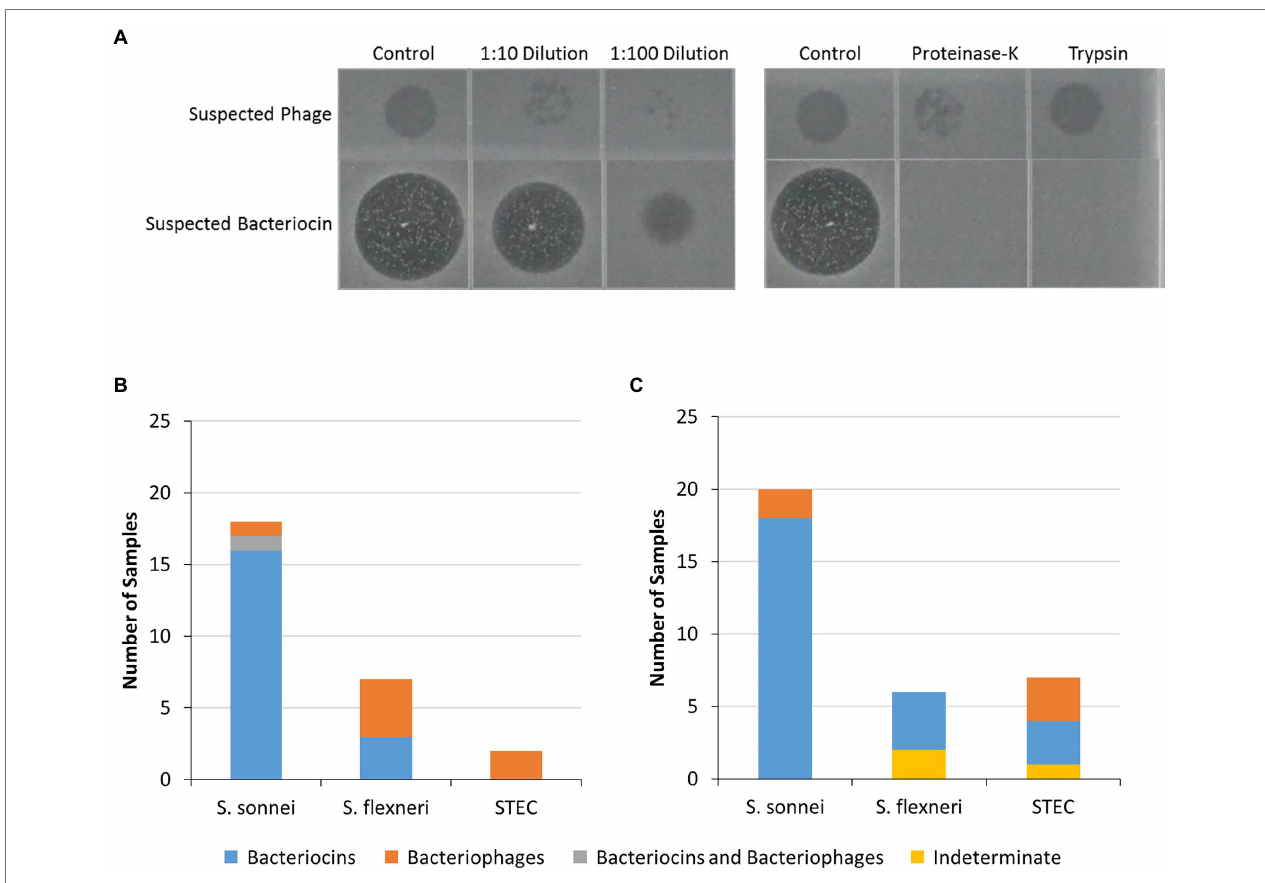
FIGURE 7 | Characterization of inhibitors in isolate and food-enrichment cell-free extracts. Cell-free extracts from food strains and enrichments which inhibited growth of at least one of the indicator strains tested were further evaluated to characterize inhibitors present. (A) The cell-free extracts were treated with two proteolytic enzymes (proteinase-K or trypsin) or were diluted (1:10 and 1:100) then spotted on soft agar containing indicator strains. Loss of activity following protein digestion indicated that growth inhibition was likely due to presence of bacteriocins (suspected bacteriocins bottom row), and resilience to protein digestion along with presence of plaques in diluted extracts indicated bacteriophage (suspected bacteriophage, top row). (B,C) Inhibitory activity of bacterial isolate extracts (B) or food enrichment extracts (C) against indicator organisms. Predicted bacteriocins are indicated by blue bars, bacteriophages (orange bars) or both (gray bars). Indeterminate samples could not be assessed due to weak zones of clearing (yellow bars).